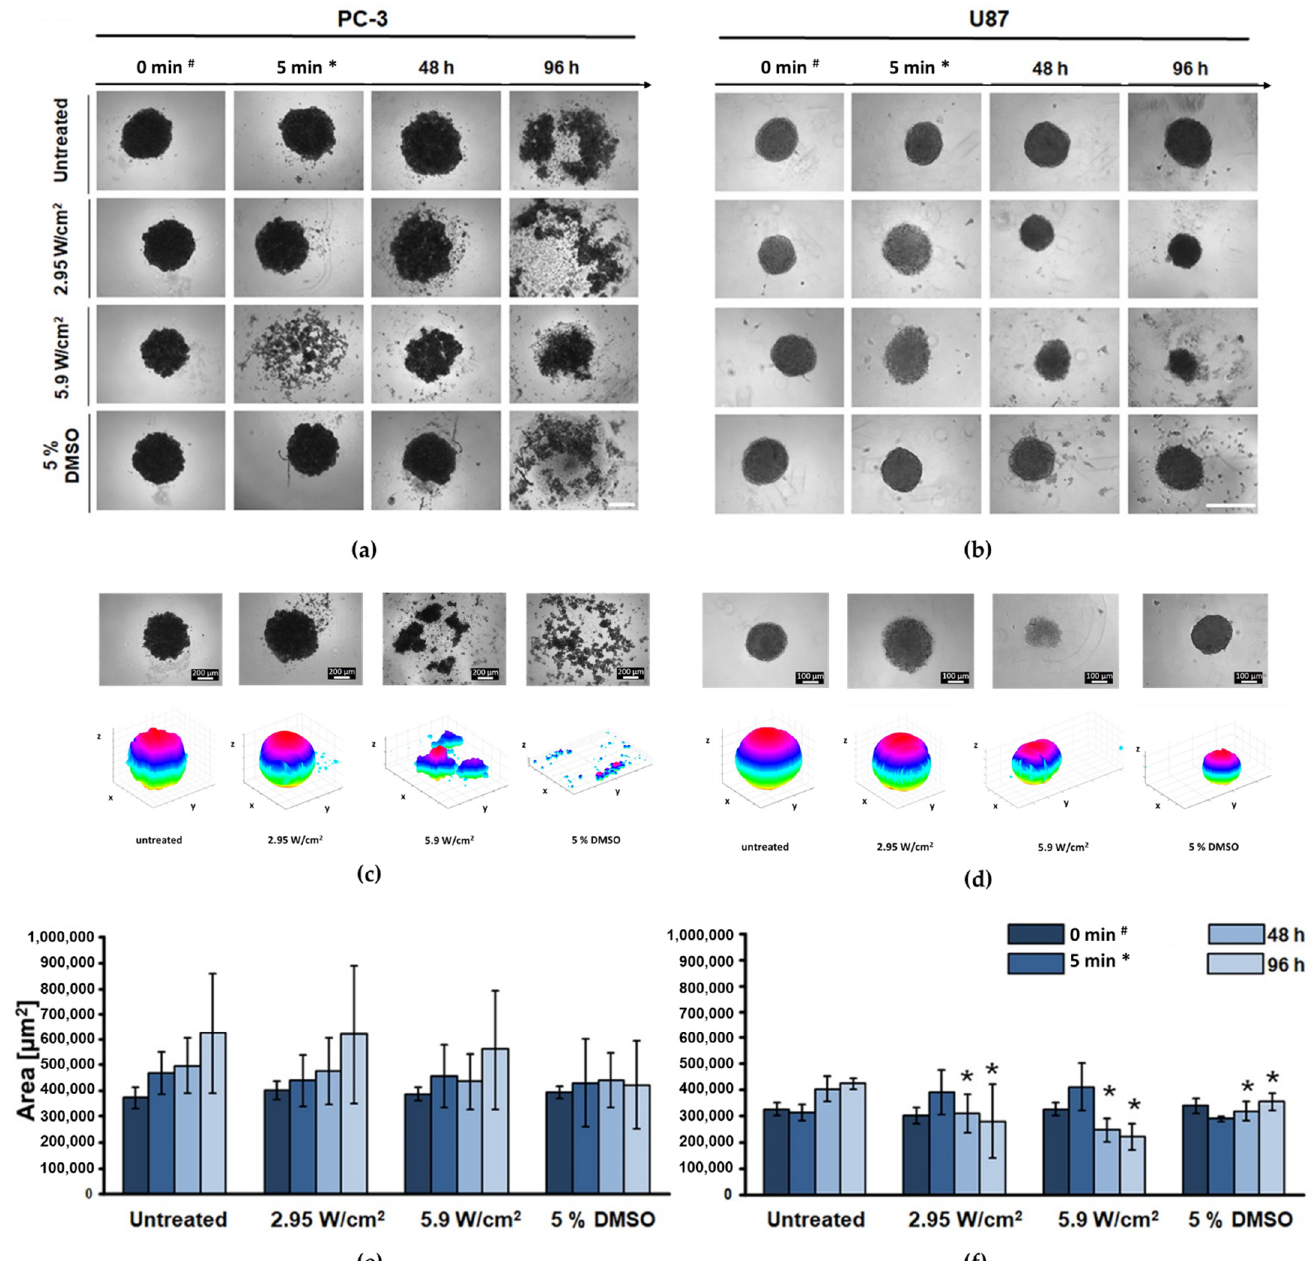
Figure 4. FUS reduced spheroid size and led to a loss of integrity. ( a , b ) Representative microscopy images showing alterations in spheroid morphology and ( c , d ) brightfield images of FUS-treated spheroids; the corresponding 3D reconstructions were obtained using ReViSP, http://sourceforge.net/p/revisp/. ( e / f ) Bar chart representation of changes in the spheroid area before, immediately, 48, and 96 h after FUS treatment at an intensity of 2.95 and 5.9 W/cm 2 , + control: +5% DMSO. Data analysis was carried out by one-way ANOVA. * Significantly different from the untreated group. ( p ≤ 0.05). # 4th day spheroid formation; * in the ‘untreated’ group only, well-to-well (re-)transfer of spheroid was carried out to equalise the impact. PC-3 cancer cell line: Scale bar = 200 μ m. U87 cancer cell line: Scale bar = 100 μ m. n = 9.